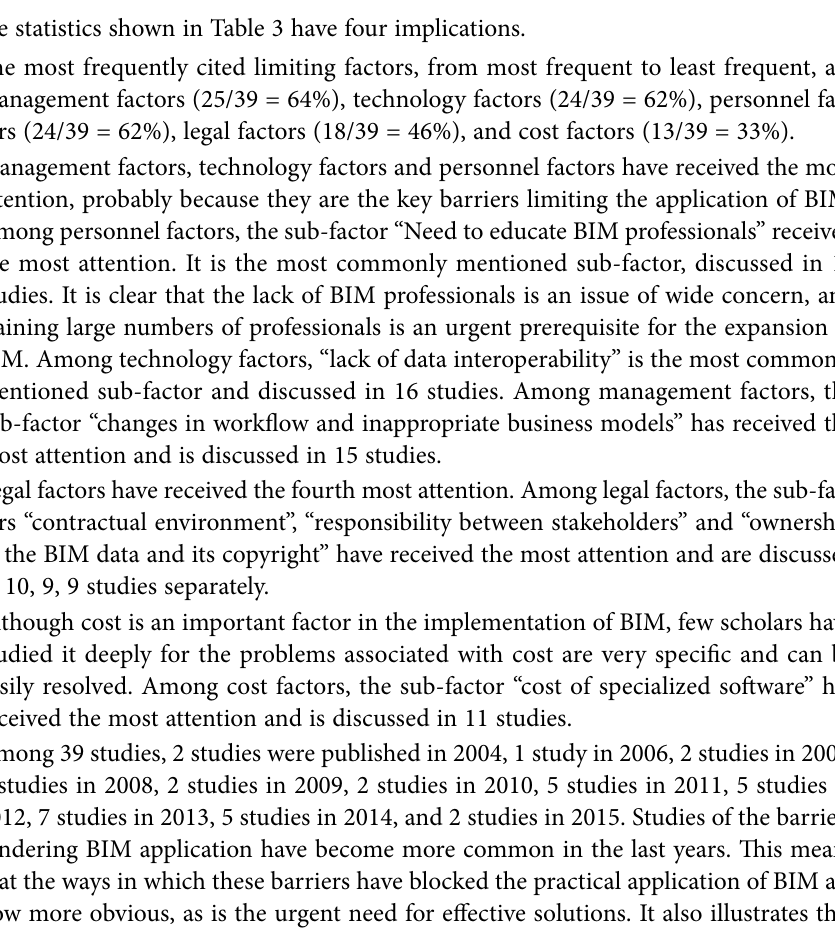
Table 3. Statistics of factors limiting the application of BIM Factors limiting the application of